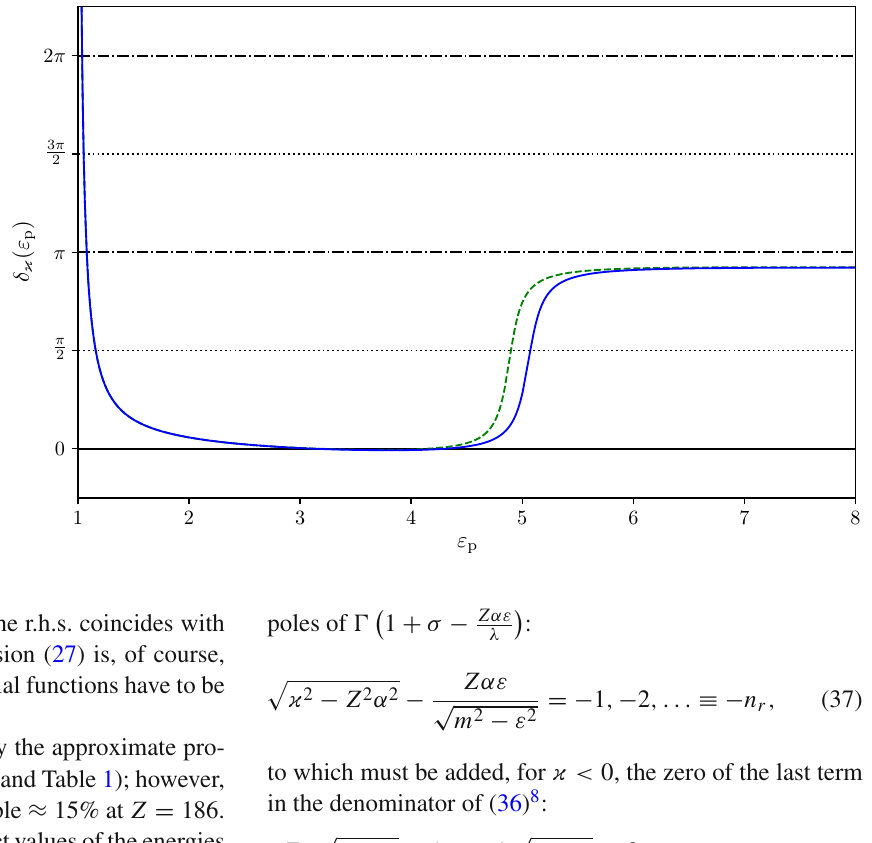
Fig. 2 Dependence on ε p of the scattering phase δ − 1 (ε p , 232 ) ( Z = 232 and (cid:3) = − 1) for a nucleus with radius R = 0 . 031 / m . The blue solid line corresponds to the exact phase, the green dashed line corresponds to the approximate